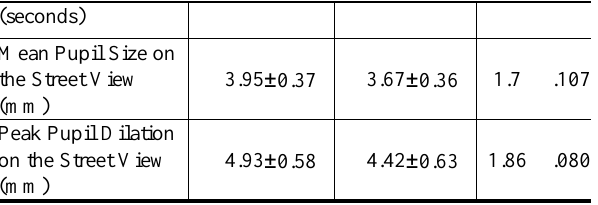
Table 2. Descriptive and inferential statistics of the